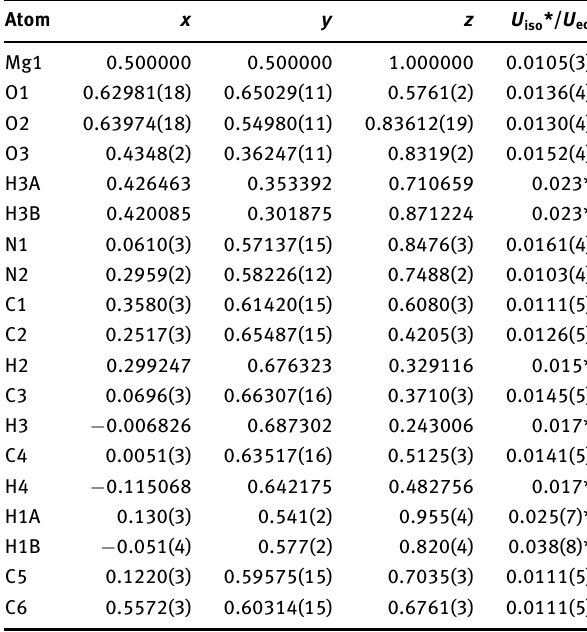
Table 2: Fractional atomic coordinates and isotropic or equivalent isotropic displacement parameters (Å 2